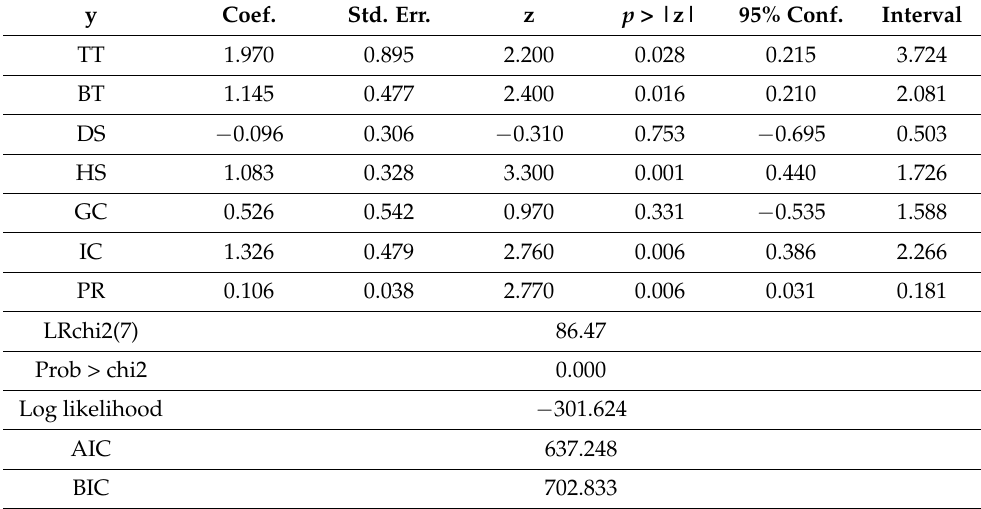
Table 5. Estimation results of mixed logit.